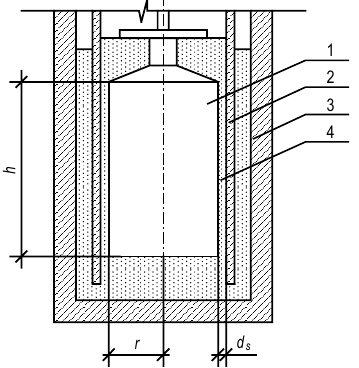
Fig. 1. Scheme for the rotational viscometer with coaxial cyl- inders: 1 – cylinder connected with a measuring scale ( r = 20 mm, h = 60 mm); 2 – internal (rotating) cylinder; 3 – exter- nal (fixed) cylinder; 4 – cement